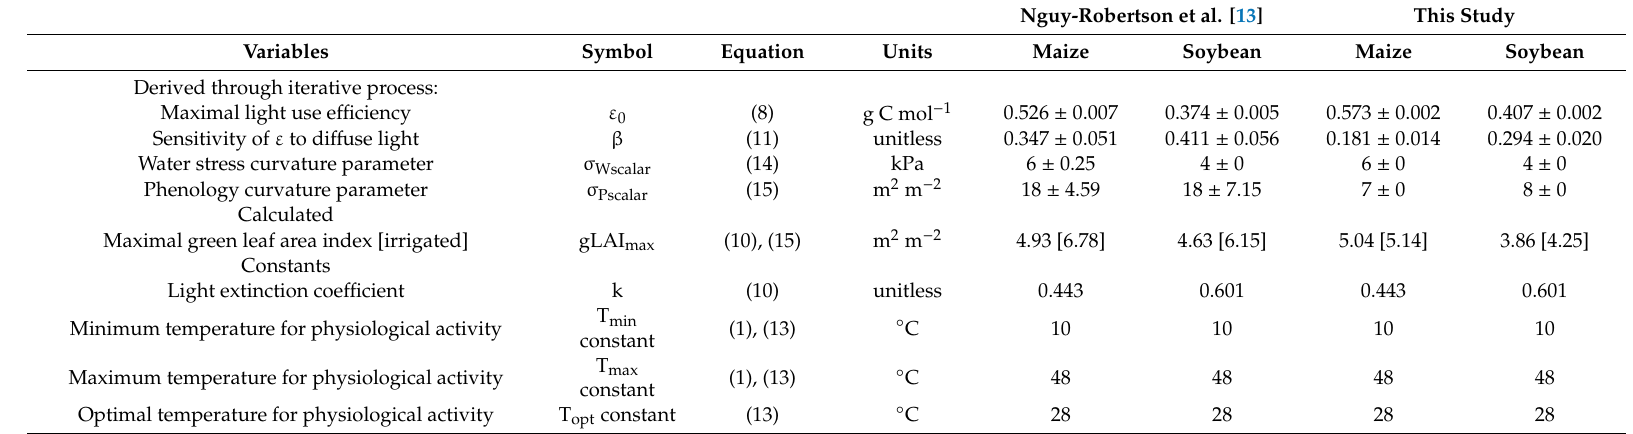
Table 4. Parameters for the calculation of scalars for the cloud-adjusted light use e ffi ciency model (LUEc). The parameters in the upper portion of the table were calculated through the iterative process while those in the lower portion of the table are model constants from Nguy-Robertson et al.